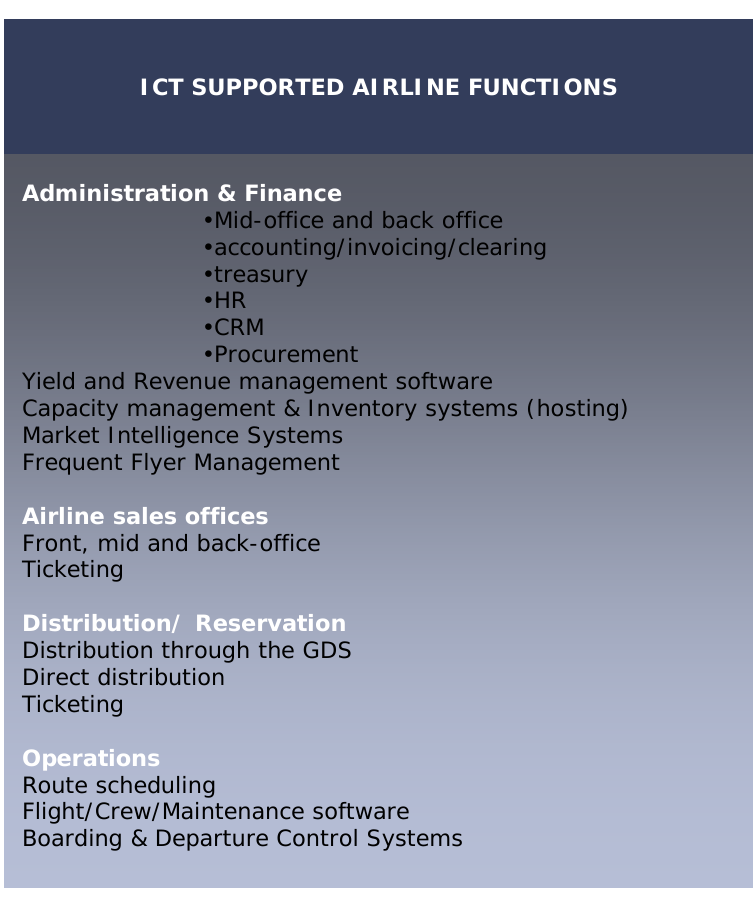
Figure 1. “Areas of ICT usage by airlines”. Source: